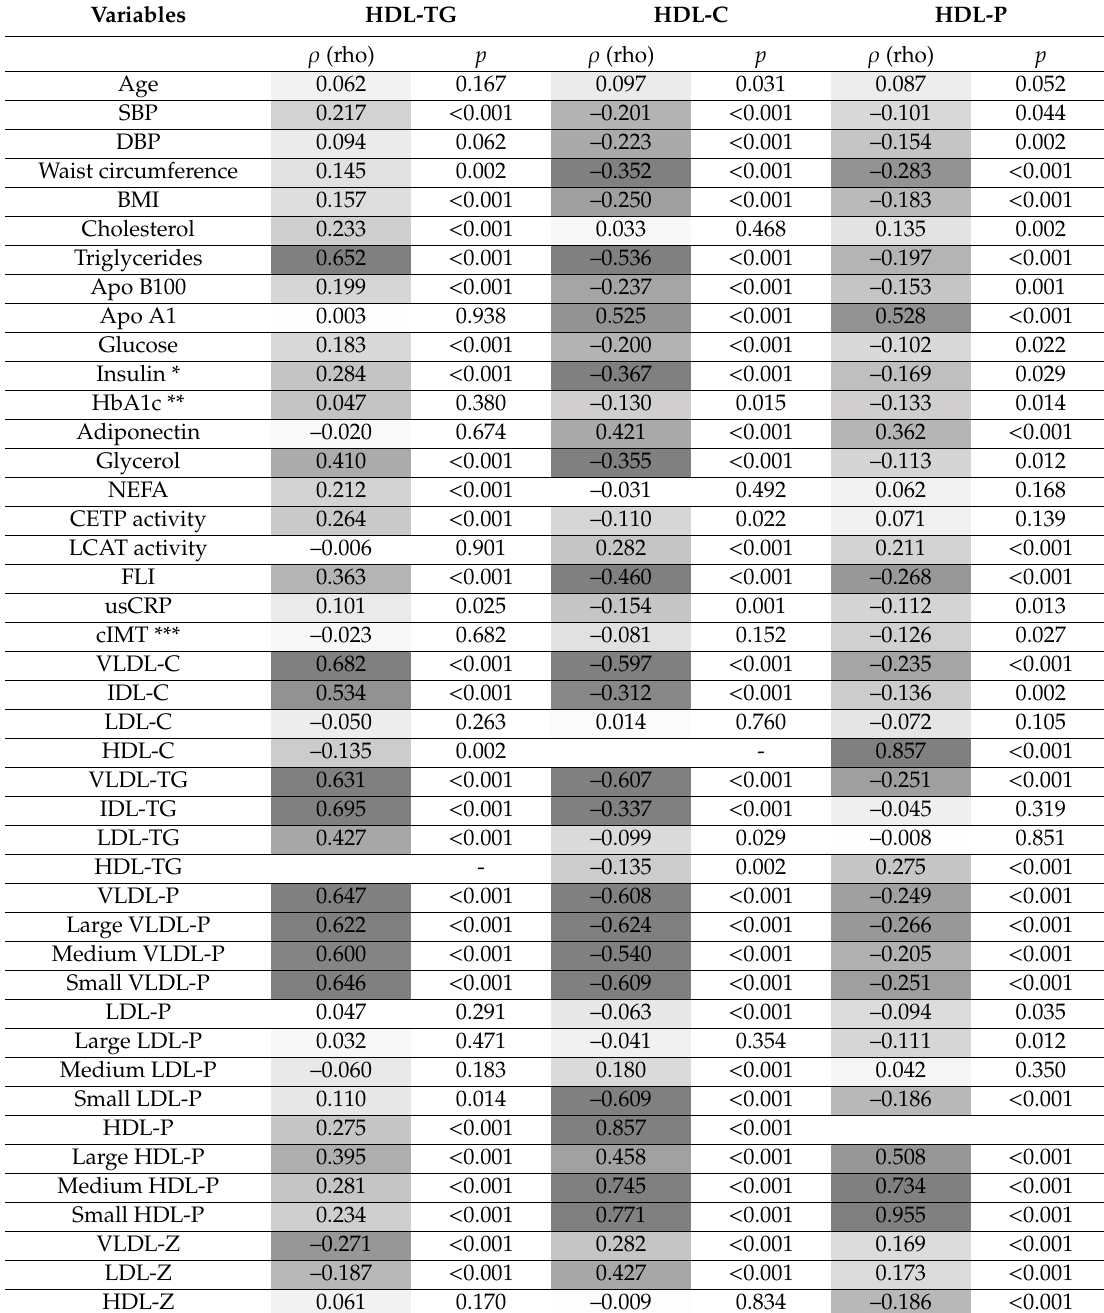
Table 2. Association of HDL-TG, HDL-C, and HDL-P with clinical and lipidomic covariables in the study